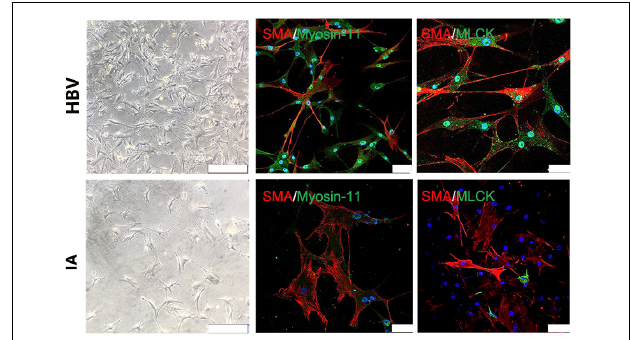
FIGURE 2 | Myosin light chain kinase primary SMCs. Bright field images show IASMCs with more irregular morphology than HBVSMCs. Double staining for SMA/myosin-11 and SMA/MLCK showed that IASMCs were less or weakly positive compared with HBVSMCs. Data are presented as the means ± SD, ∗ p < 0.05, bar = 100 µ m. HBVSMC, human brain vascular smooth muscle cell; IASMC, intracranial aneurysm smooth muscle cell.